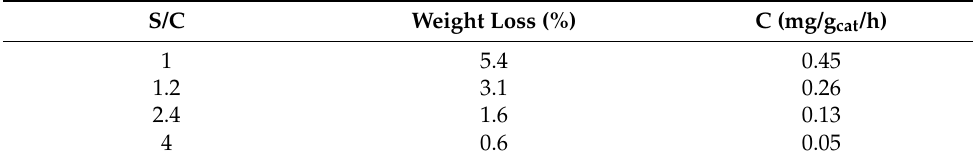
Figure 5. TEM images of the carbon deposits formed on the Ni/CeZrO 2 catalyst during toluene steam reforming carried out at S/C = 1. Table 4. The weight loss and carbon deposition rate for the Ni/CeZrO 2 samples after toluene steam reforming carried out at different S/C ratios at temperatures ranging from 420 to 800 ◦ C (t c = 0.36 s, TOS at each temperature = 24